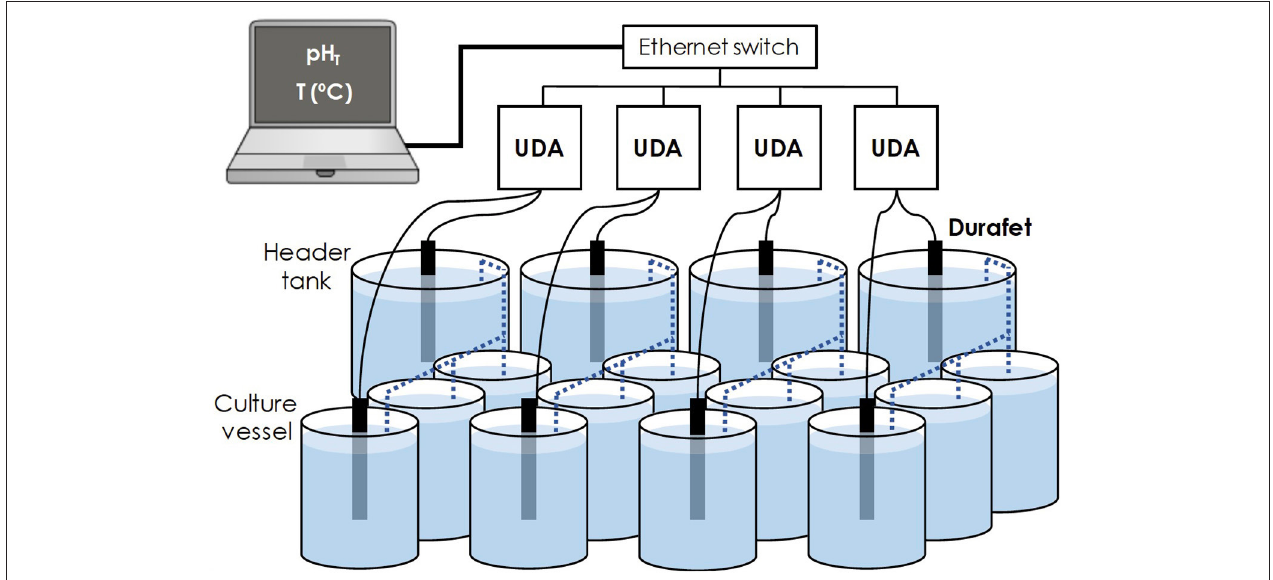
FIGURE 1 | Diagram of four UDA units with a total of eight Durafet pH electrodes in an experimental set up. This design includes four experimental treatments, each of which have three, downstream, (pseudo)replicate larval culture vessels. Dashed lines indicate seawater